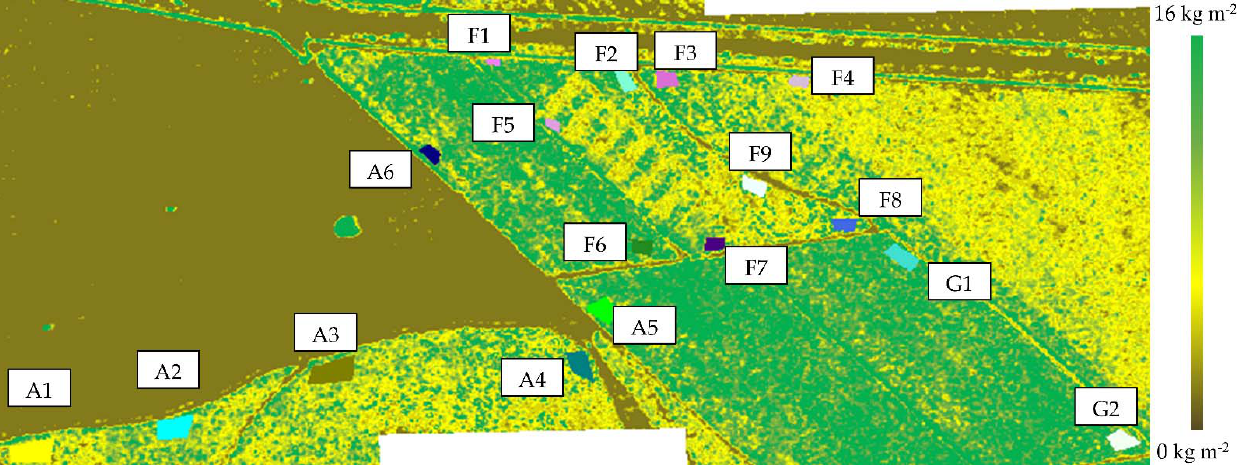
Figure 17. Estimated AGB maps for the survey flights on 16 July 2020, over test-site areas 1, 6, and 7 and the 17 selected sections.